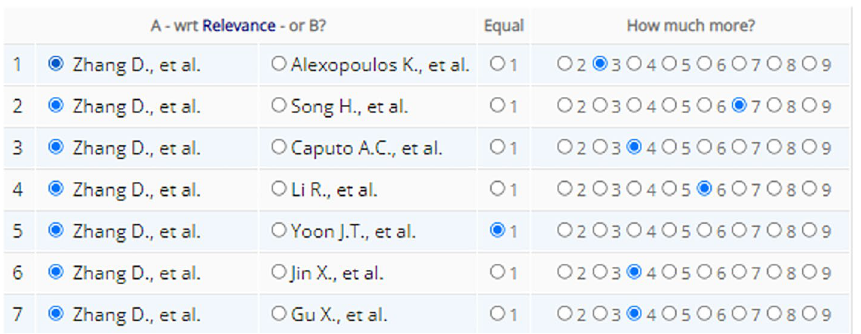
Figure 4. Pairwise comparison of Zhang et al. proposed resilience metric against other selected metrics under criteria of relevance (screenshot from AHP-OS